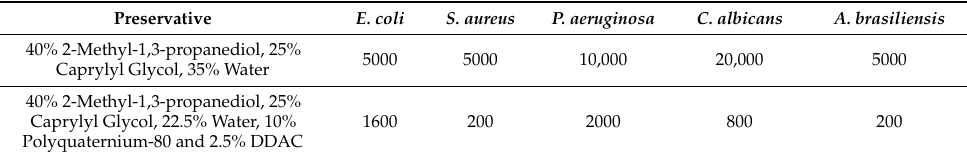
Table 5. MIC values (expressed in ppm) of 2-Methyl-1,3-Propanediol 40%, Caprylyl Glycol 25%, Water 35%; and 2-Methyl-1,3-Propanediol 40%, Caprylyl Glycol 25%, Water 22.5%, Polyquaternium-